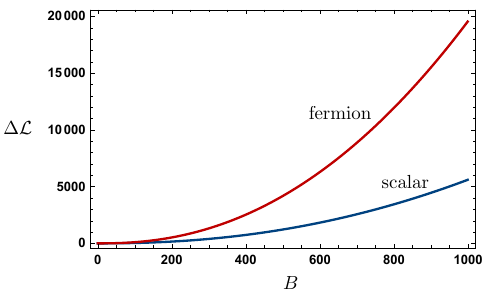
Figure 5 . Numerical integration of the Euler-Heisenberg Lagrangian in eq. (C.1) for large values of | ~B | , with m = e = 1 . For both the fermion and scalar completion, ∆ L is positive and